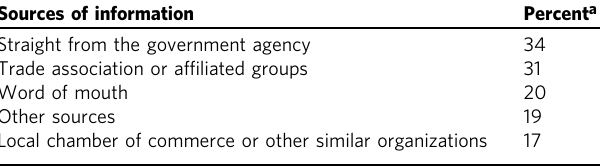
Table 4 Sources of information for new regulatory policies ( n =